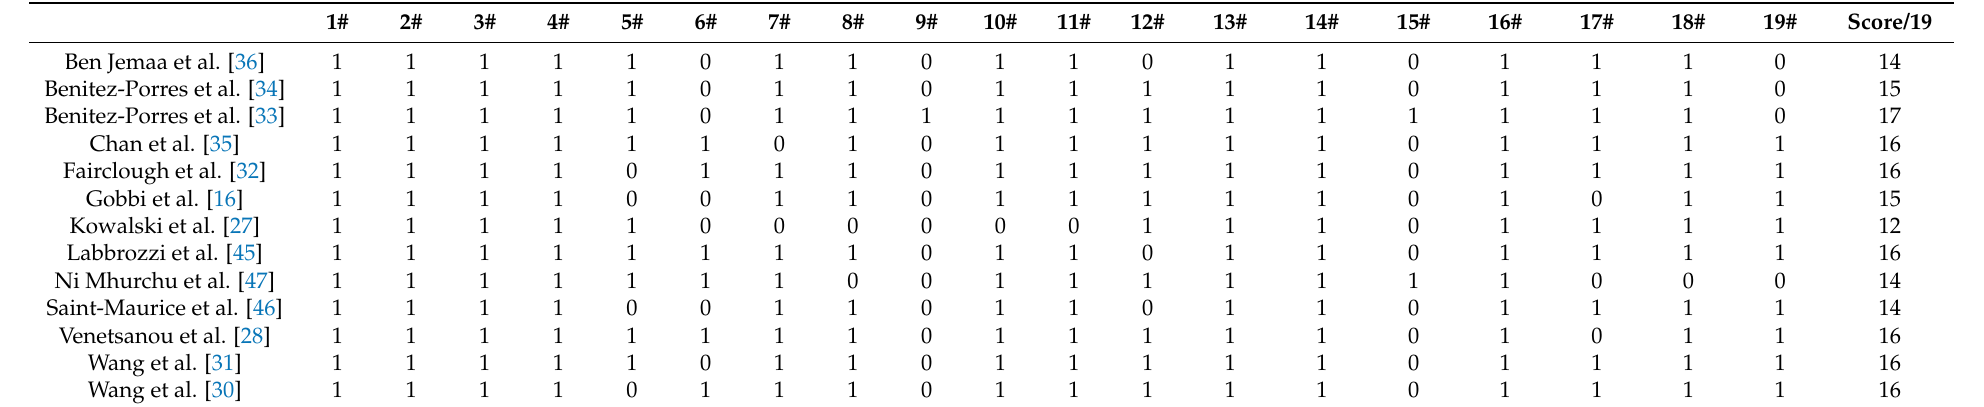
Table 2. The Strengthening the Reporting of Observational Studies in Epidemiology checklist (STROBE) scores and summary of studies’